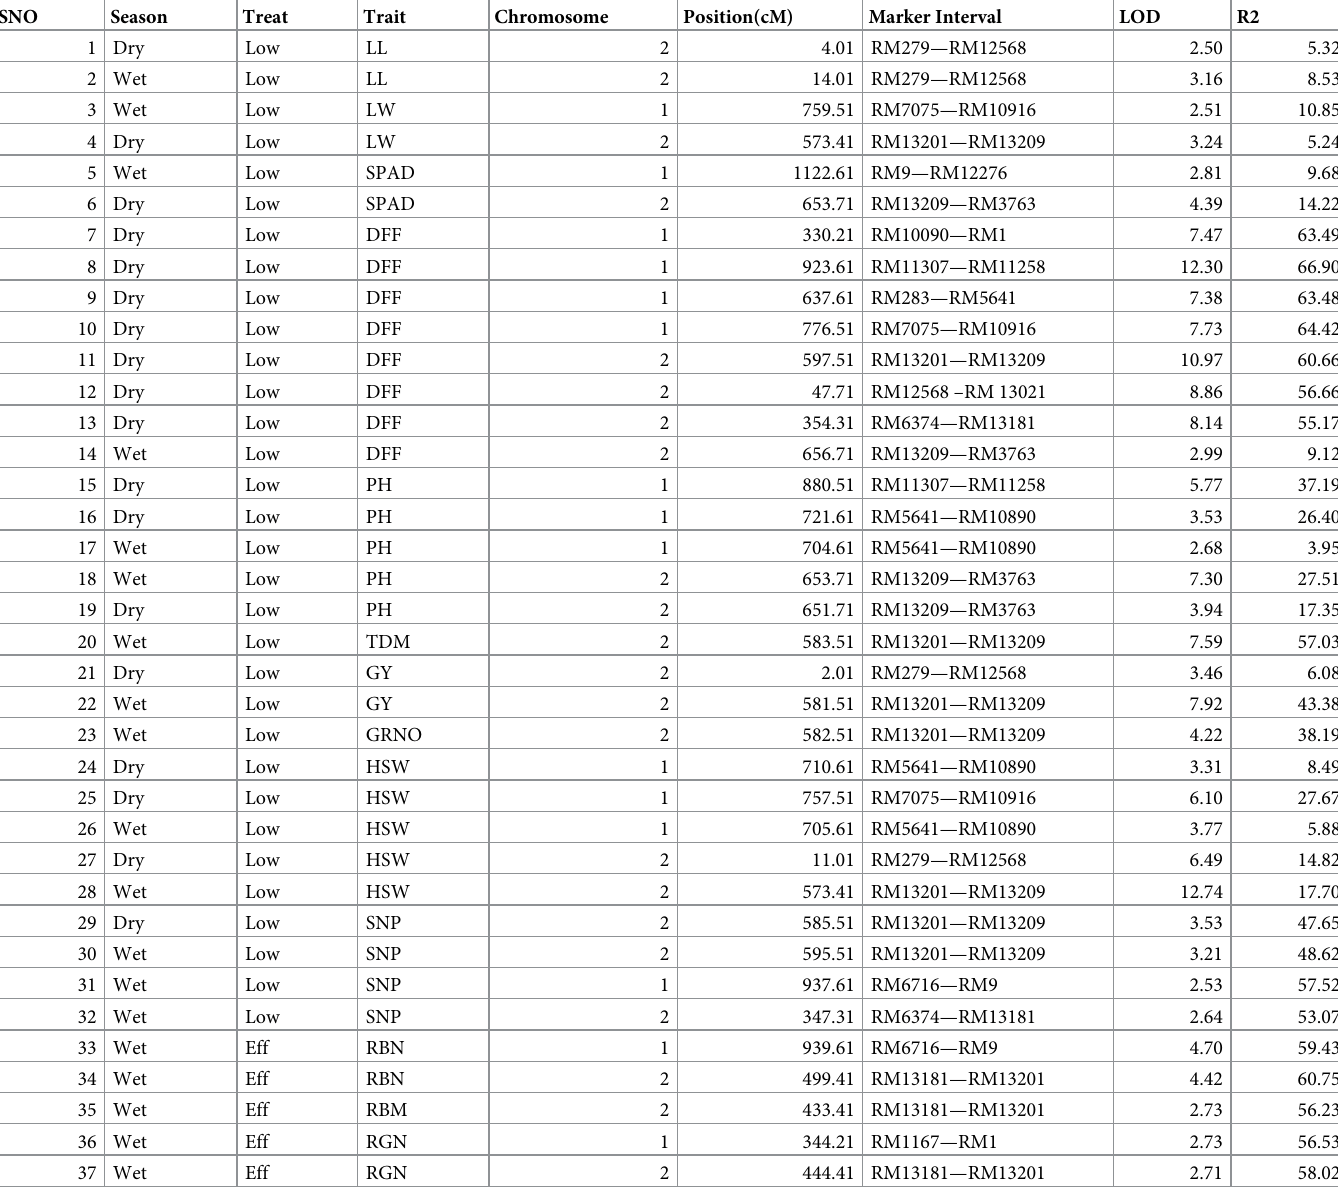
Table 3. Details of identified QTL for leaf, agro-morphological, yield and yield related traits and N content and its indices identified through CIM under low N in WS and DS. SNO